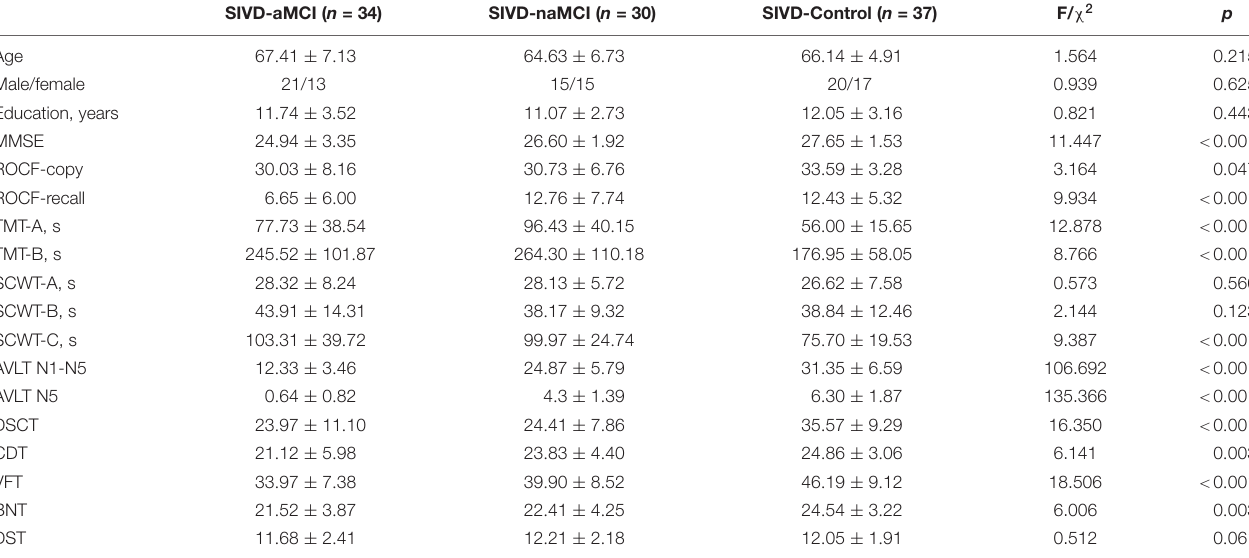
TABLE 1 | Demographic and clinical